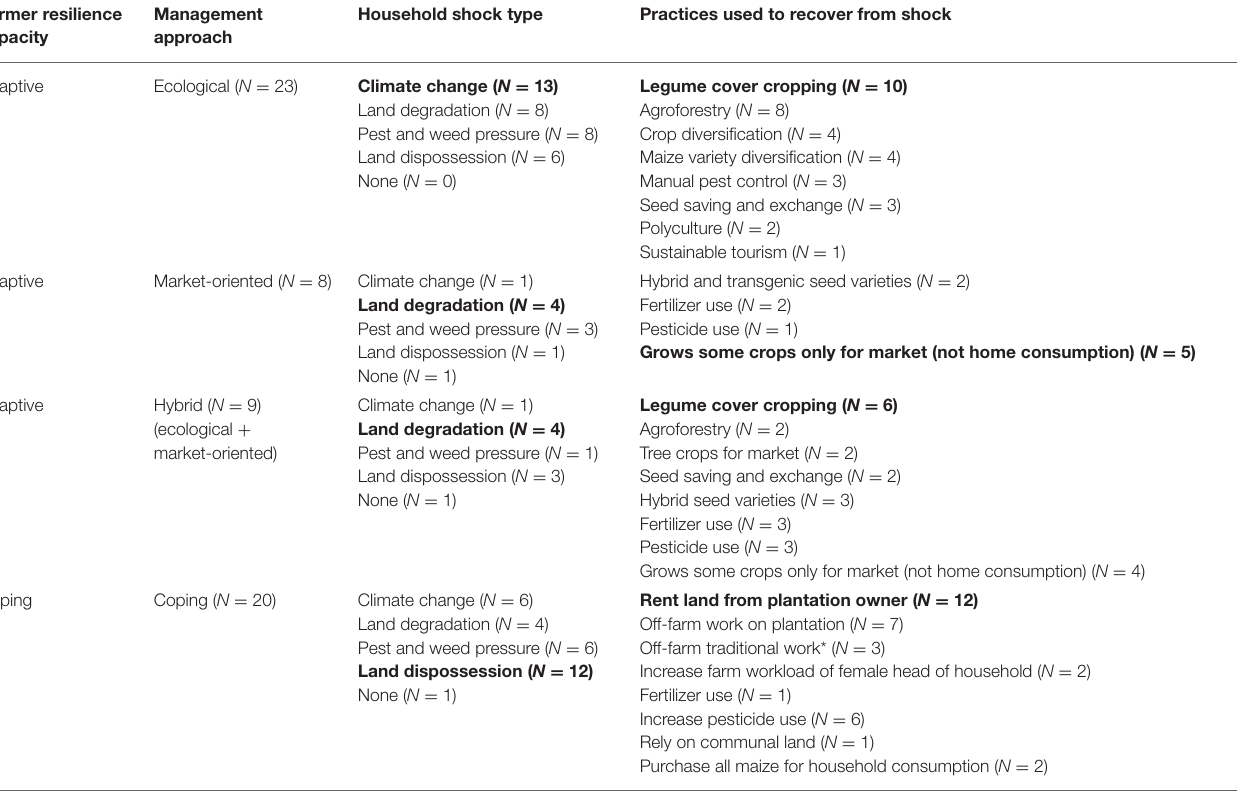
TABLE 5 | Coping and adaptative strategies used by farmers in the Guatemalan case study to respond to community-level and idiosyncratic shocks. Farmer resilience capacity